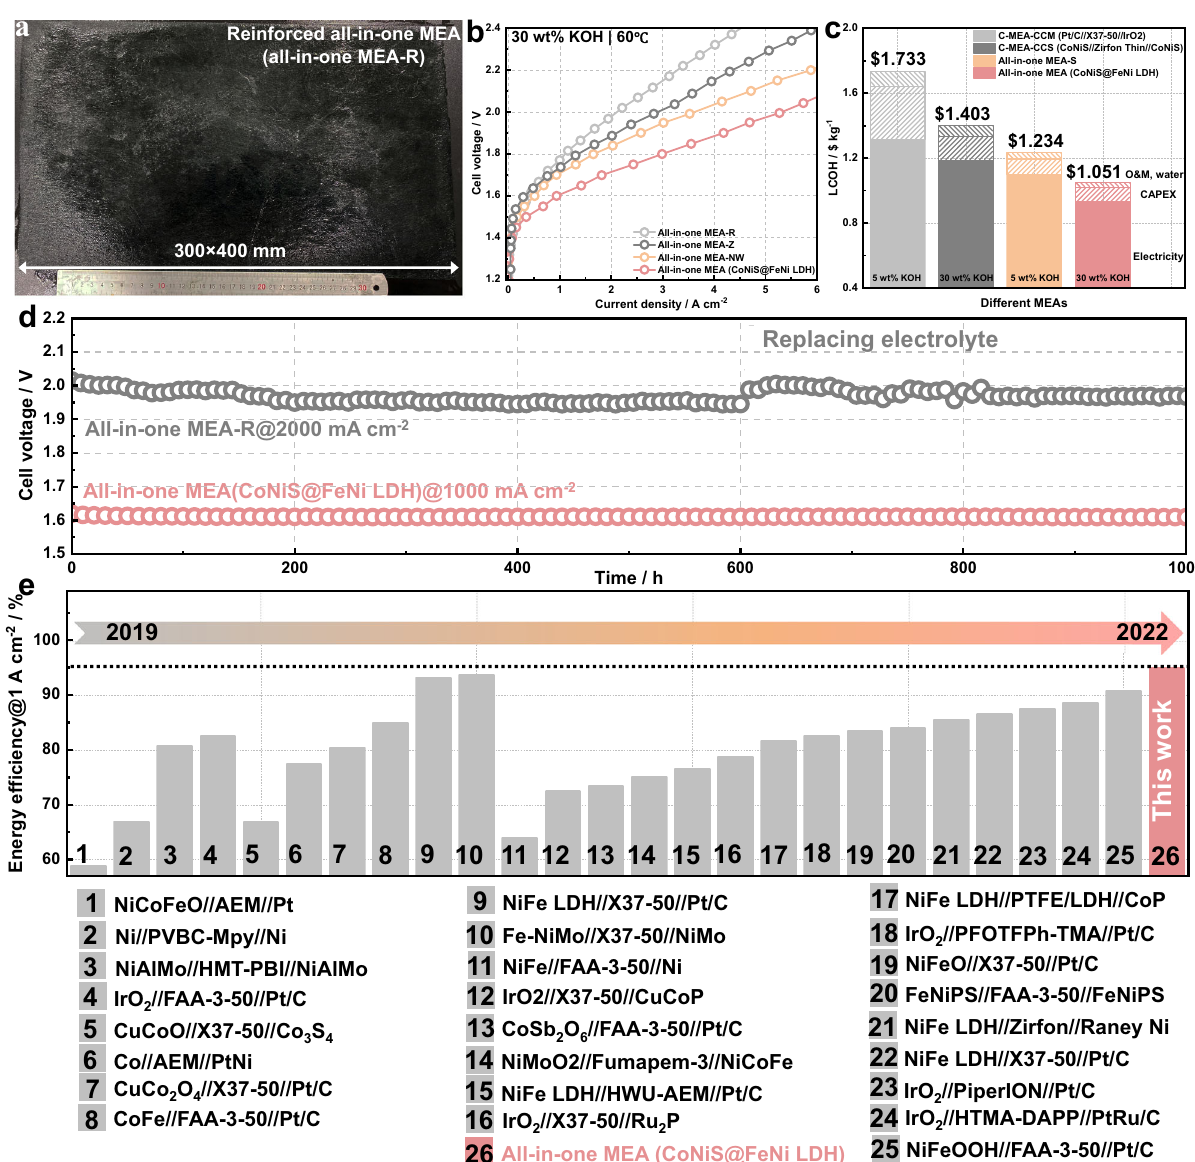
voltage-time plots for the all-in-one MEA-R and all-in-one MEA (CoNiS@FeNi LDH) atconstantcurrentdensityin30wt%KOHat60°C. e Energyef fi ciencycomparison of the all-in-one MEA (CoNiS@FeNi LDH) with reported alkaline water electrolysis at 1Acm − 2 (Supplementary Table